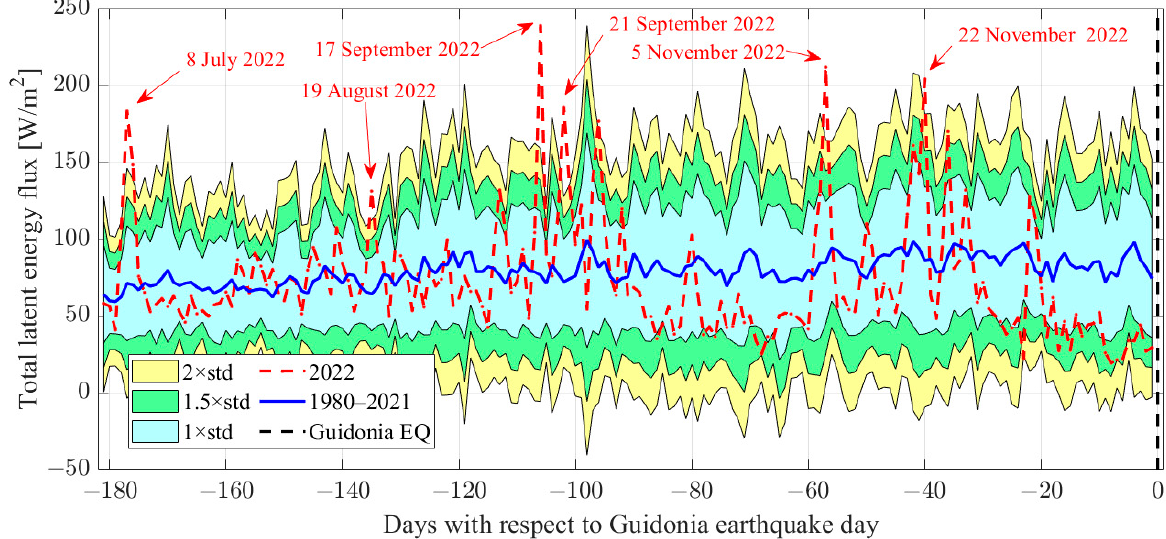
Figure 4. Total latent energy flux time series from 4 July 2022 to 31 December 2022 (i.e., from six months before until the day before the ML = 3.3 Guidonia 1 January 2023 earthquake, red dashed line). The blue line represents the historical mean calculated from 1980 to 2021 in the same period and region. Cyan, green, and yellow bands represent 1.0, 1.5, and 2.0 standard deviations of the historical values from 1980 to 2021. The horizontal axis represents the day before the Guidonia earthquake for the red dashed line (i.e., the 2022 time series), and the mean and standard deviation of the historical values are computed on the same day of the previous years. The vertical dashed black line represents the Guidonia earthquake (EQ) occurrence time. A red arrow with the specific date is reported for the anomalous days, i.e., the values that exceeded two standard deviations.